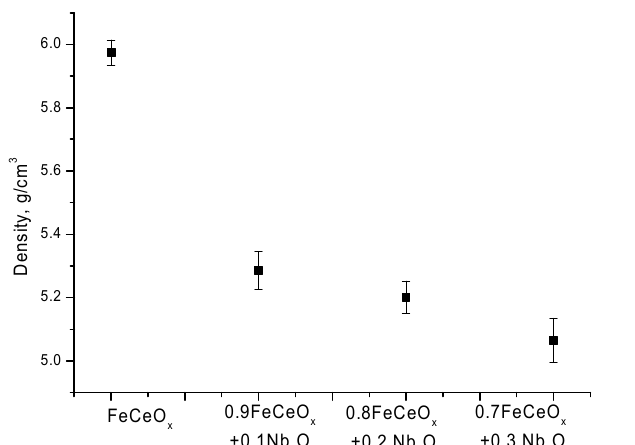
Figure 6. Graph of changes in the density of nanoparticles depending on the concentration of the dopant. The magnetic characteristics of nanoparticles depending on the concentration of the dopant were studied using a vibrating magnetometer, hysteresis loops are shown in Figure 7, the results of calculating the magnetic characteristics are presented in Table 2.